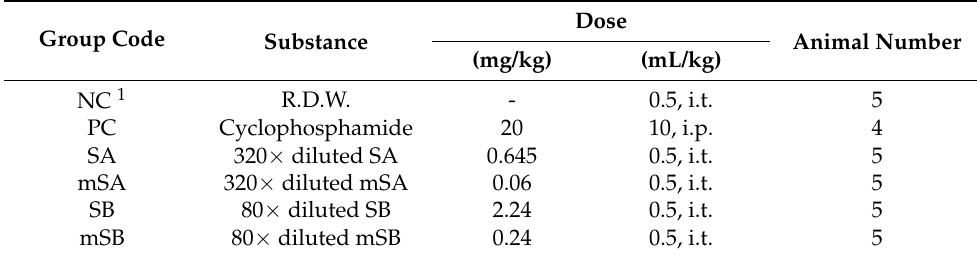
Table 3. Treatment groups and doses of the rat peripheral blood micronucleus test and acute pulmonary toxicity on Day